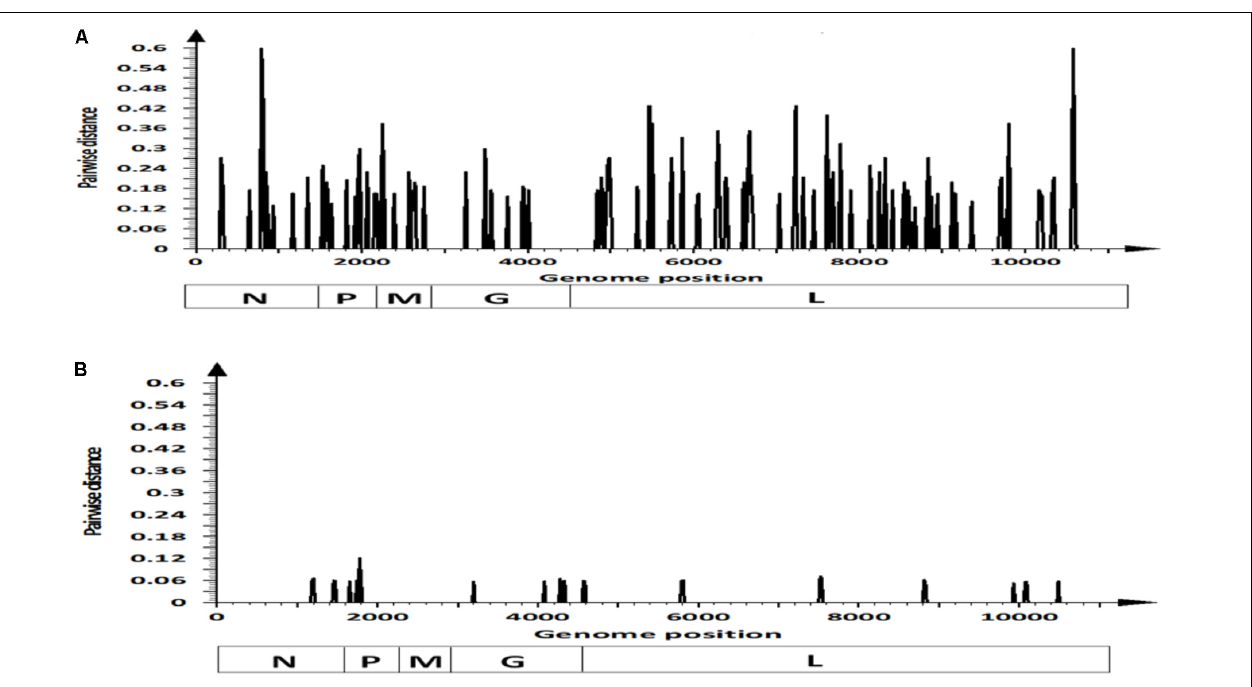
FIGURE 2 | Pairwise distance analysis contrasting differences in: (A) synonymous and (B) non-synonymous sites within coding regions of viral strains NJ0612NME6 and NJ0806VCB. Bars in the graphics represent pairwise distance comparisons using 20 nt